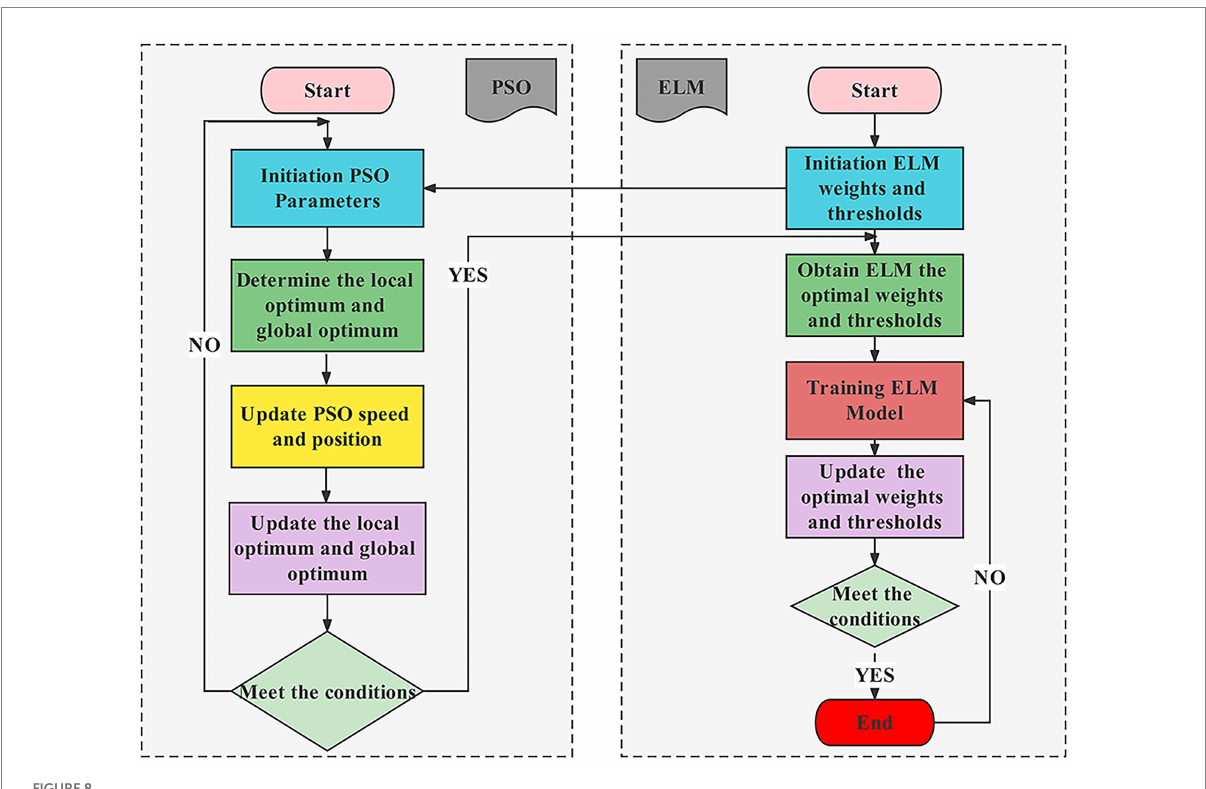
FIGURE 8 Flow chart of the PSO-ELM